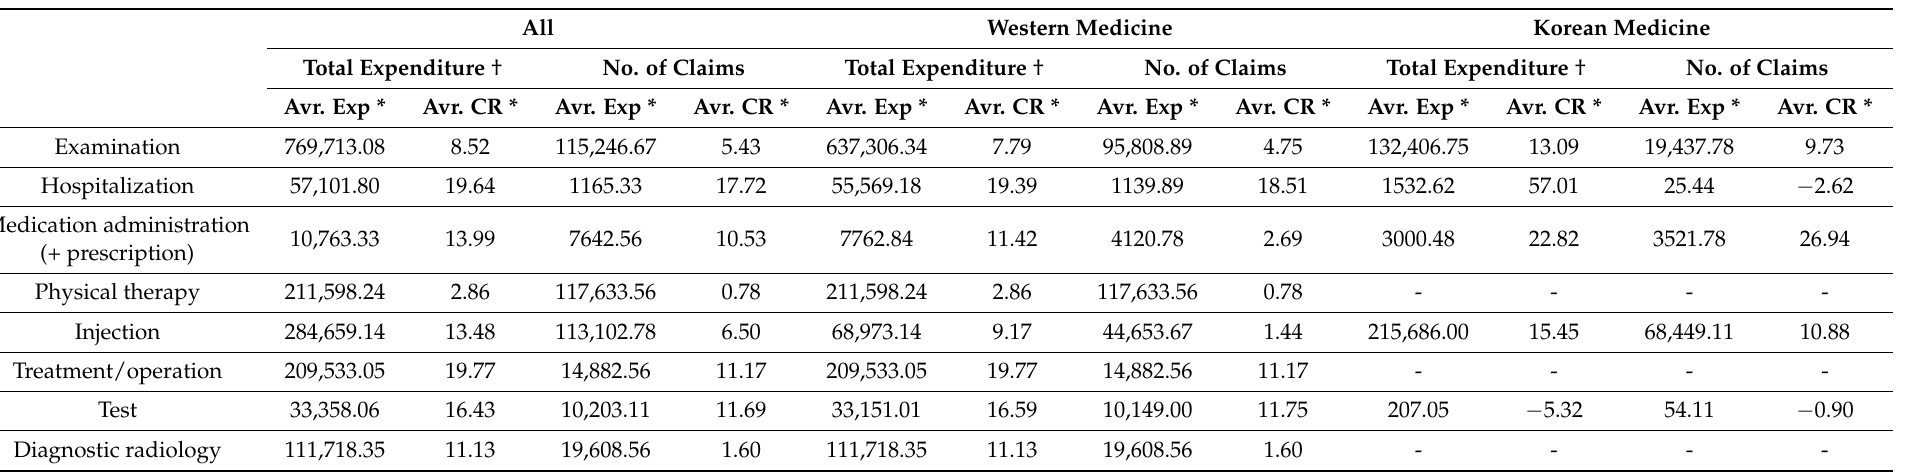
Table 3. Average expenditure † and total number of claims, average change rate over nine